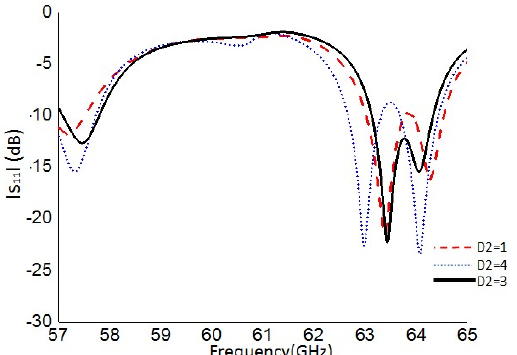
Figure 7. Simulated return loss for the proposed antenna with various distances between the double T-shapes (unit in mm).